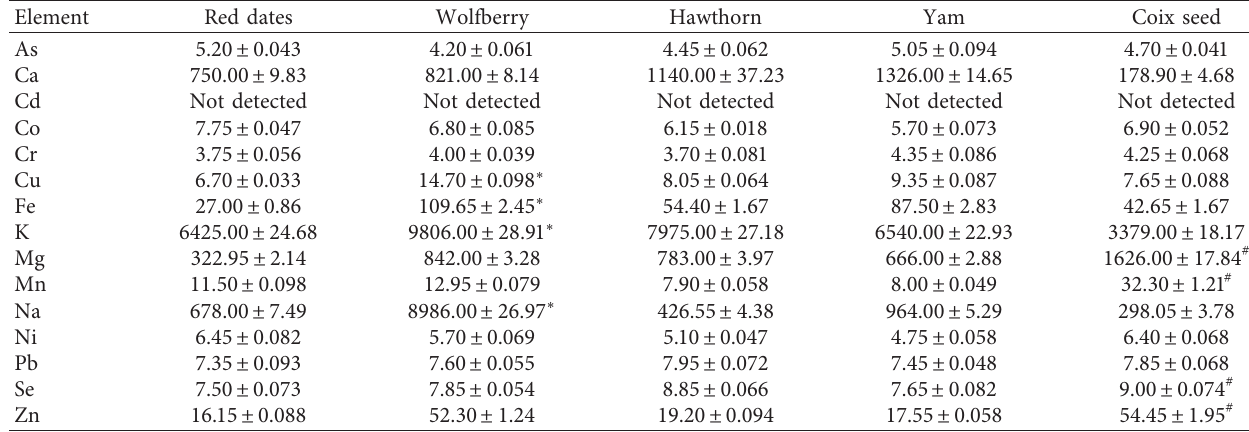
Table 5: Measurement results of